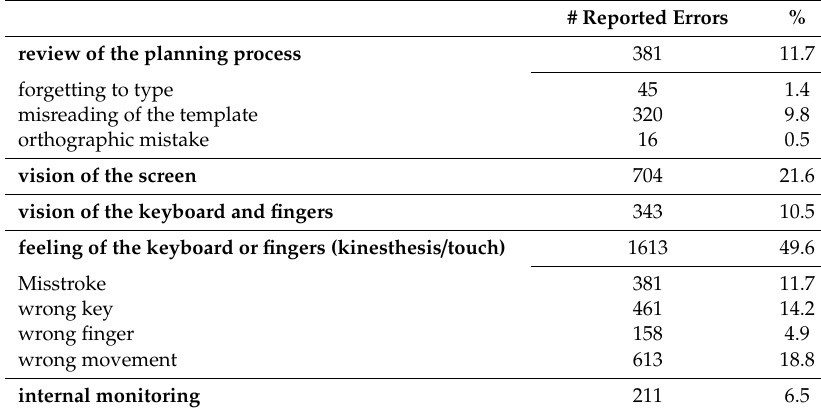
Table A2. List of sources for error detection and their subcategories. Denoted is the frequency (sum over participants) with which each source was mentioned (# reported errors) and the percentage of each source of reported errors